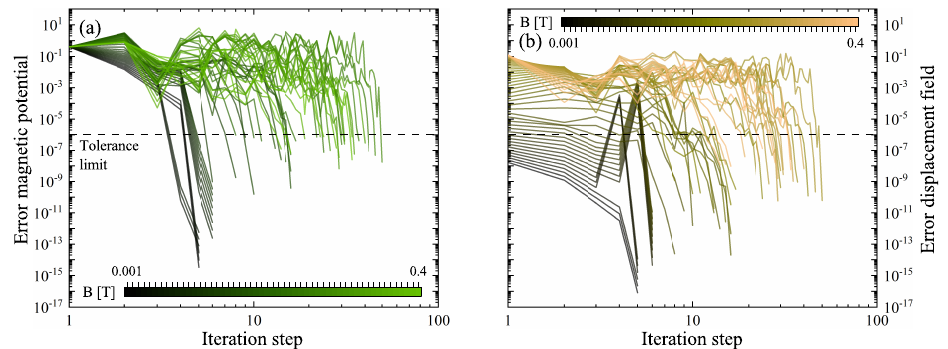
Figure A2. Convergence curves for the solution of the presented model with t Ni = 100nm: ( a ) magnetic potential, ( b ) displacement field.